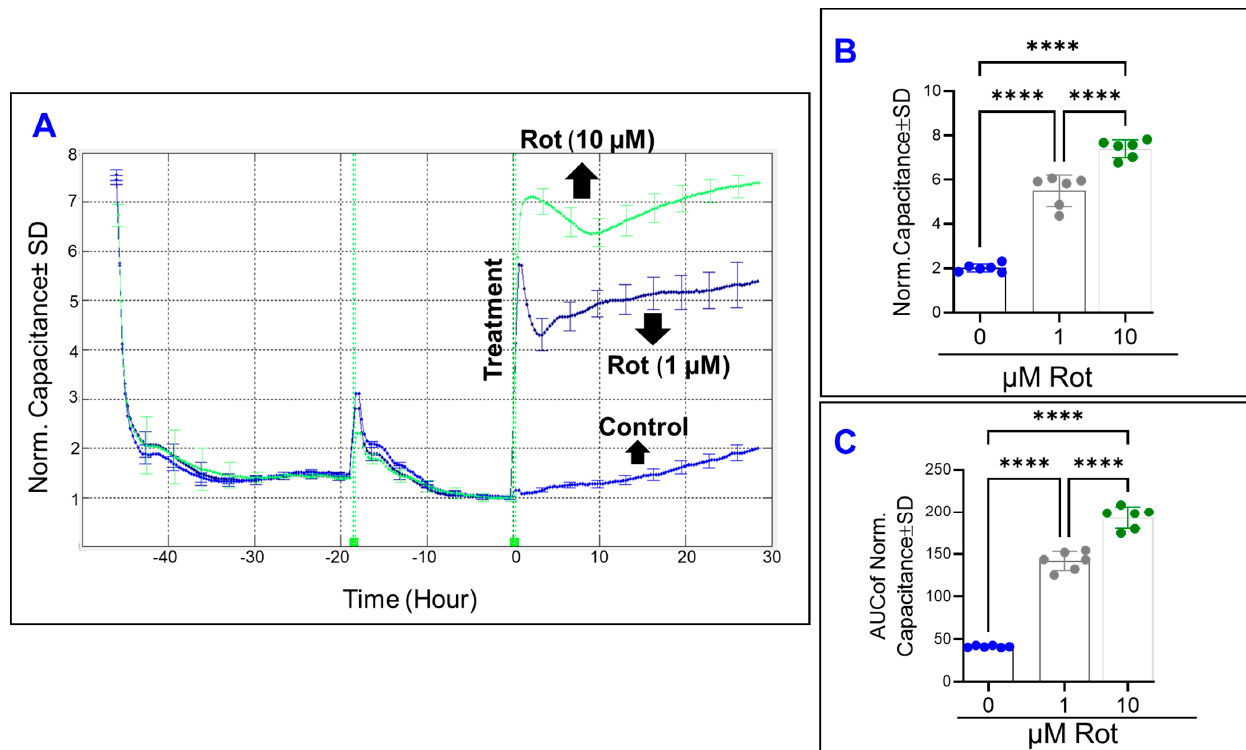
Figure 8. Real-time measurement of human retinal endothelial cells’ spreading capacity treated with an electron transport chain (ETC) complex I inhibitor (rotenone, Rot). ( A ) The spreading capacity of HRECs over the electrode after treatment with vehicle (DMSO) or Rot (1 and 10 µM) was measured at an AC frequency of 64,000 Hz and represented by plotting normalized capacitance vs. time. The capacitance value at time 0 (C 0 ) was used to normalize all other capacitance measurements. ( B ) The bar graph represents normalized capacitance measured at the time (t = 30 h). ( C ) AUC of the normalized capacitance measure between the time interval 0 and 30 h. Statistical analysis was performed using the ANOVA test followed by the Tukey post hoc test. Abbreviations: Norm, normalized; AUC, area under the curve; ****, p ≤ 0.0001; ns, no significance.